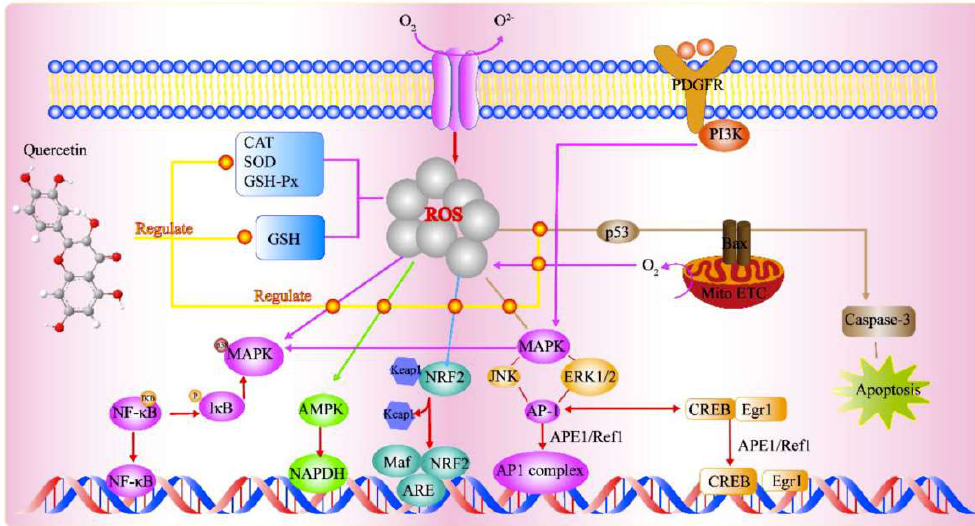
Figure 13. The antioxidant signaling pathway is regulated by quercetin. Reproduced from the permission of ref [158].